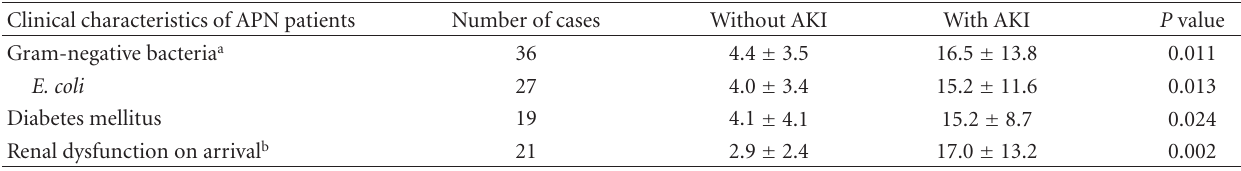
Table 3: Subgroup analysis of urinary MIF levels between APN patients with diabetes, renal dysfunction, or microbiological